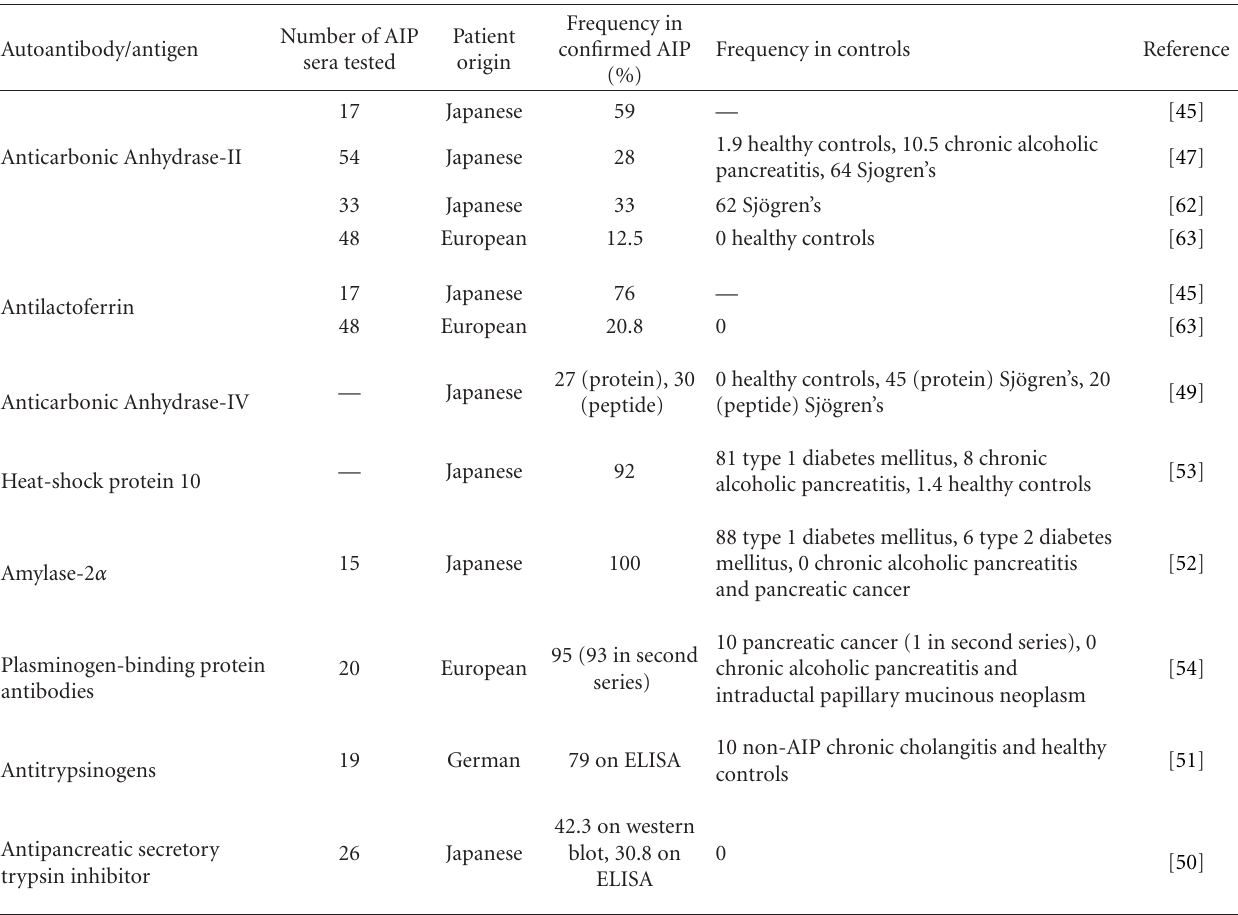
Table 1: Main disease-related autoantibody specificities in autoimmune pancreatitis. Several autoantibodies have been detected in the sera of patients with autoimmune pancreatitis (AIP). Although none have been established to be disease specific, it appears that a loss of tolerance to several pancreatic antigens may be involved in the initiation of AIP. The prevalence of antibodies against carbonic anhydrase, lactoferrin, heat-shock protein 10, amylase alpha, plasminogen-binding protein, and pancreatic secretory trypsin inhibitor antigens, key references of studies investigating autoantibodies against these antigens as well as the origin of the cohorts are provided. Information regarding conventional autoantibodies, such as, antinuclear and smooth muscle autoantibodies is provided within the